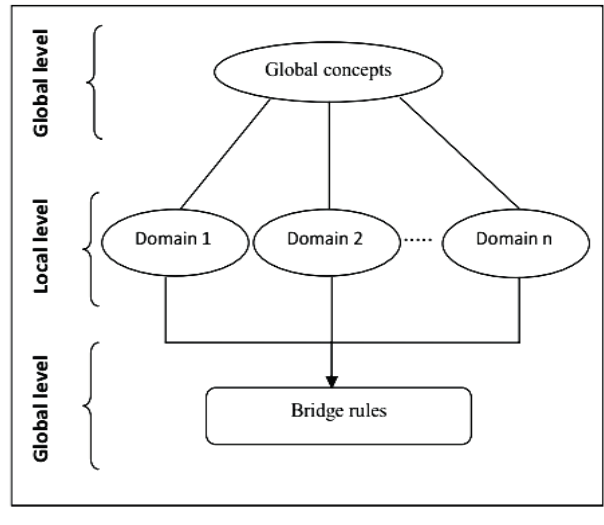
Fig. 5. The cross-domain